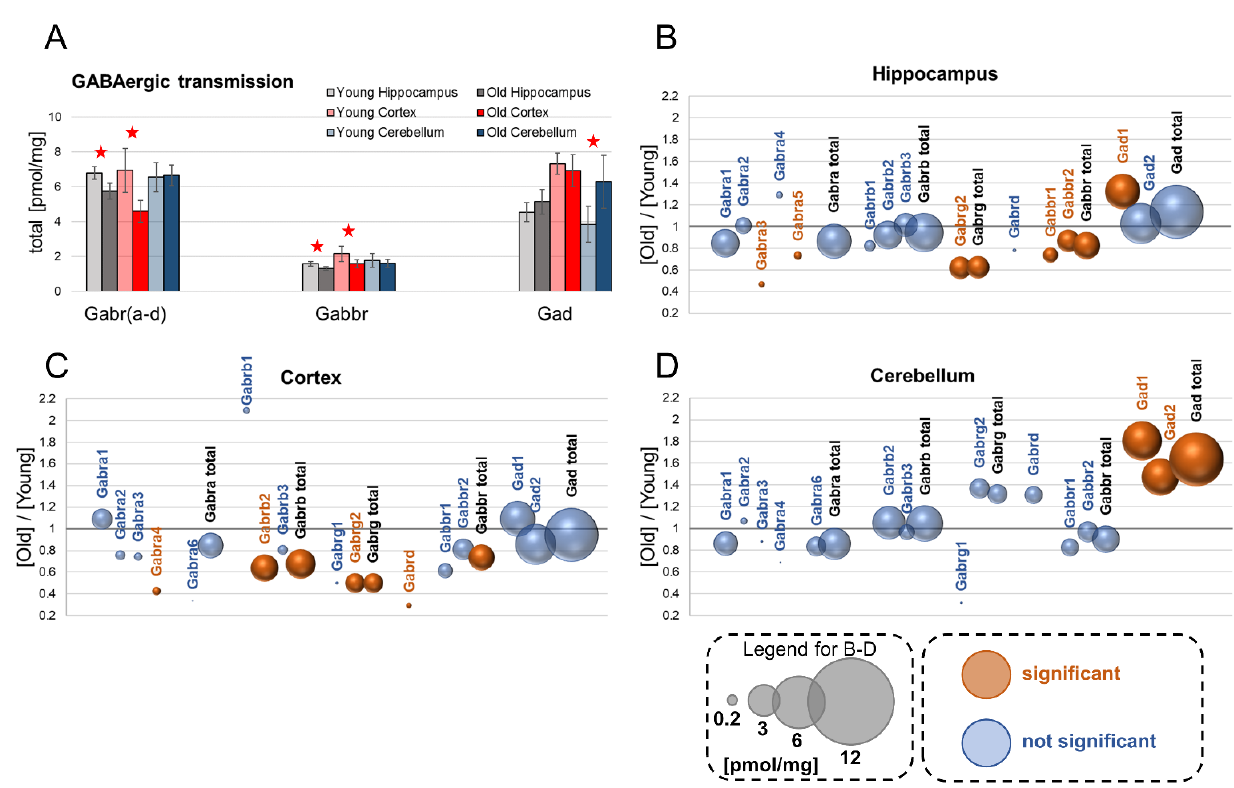
Figure 2. Changes in proteins involved in GABAergic transmission upon aging. Total concentrations of various receptor families in brains structures of young and old animals ( A ) (* p < 0.05). Plots ( B–D ) show ratios of protein concentrations in old vs. young brain structures: hippocampus ( B ), cortex ( C ) and cerebellum ( D ). The size of bubbles is proportional to the average protein concentration in the respective old brain structures. Statistically significant differences are shown as the red bubbles.